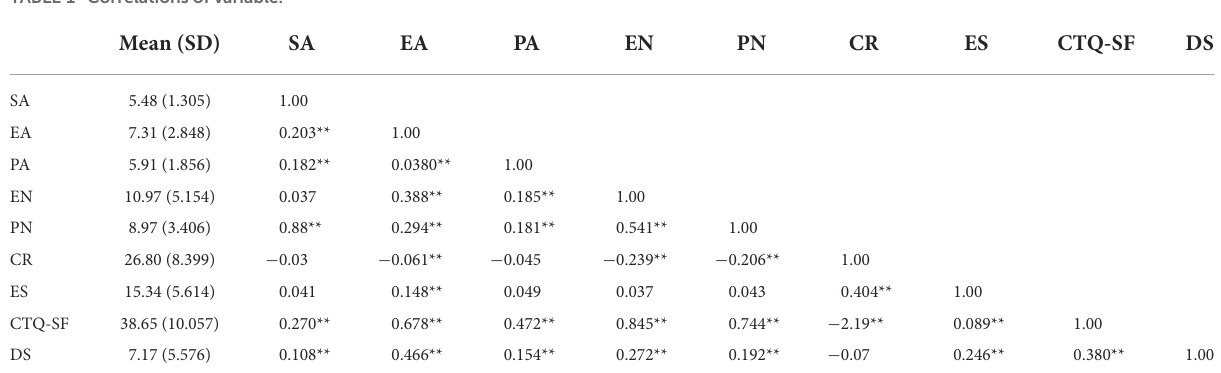
TABLE 1 Correlations of variable.